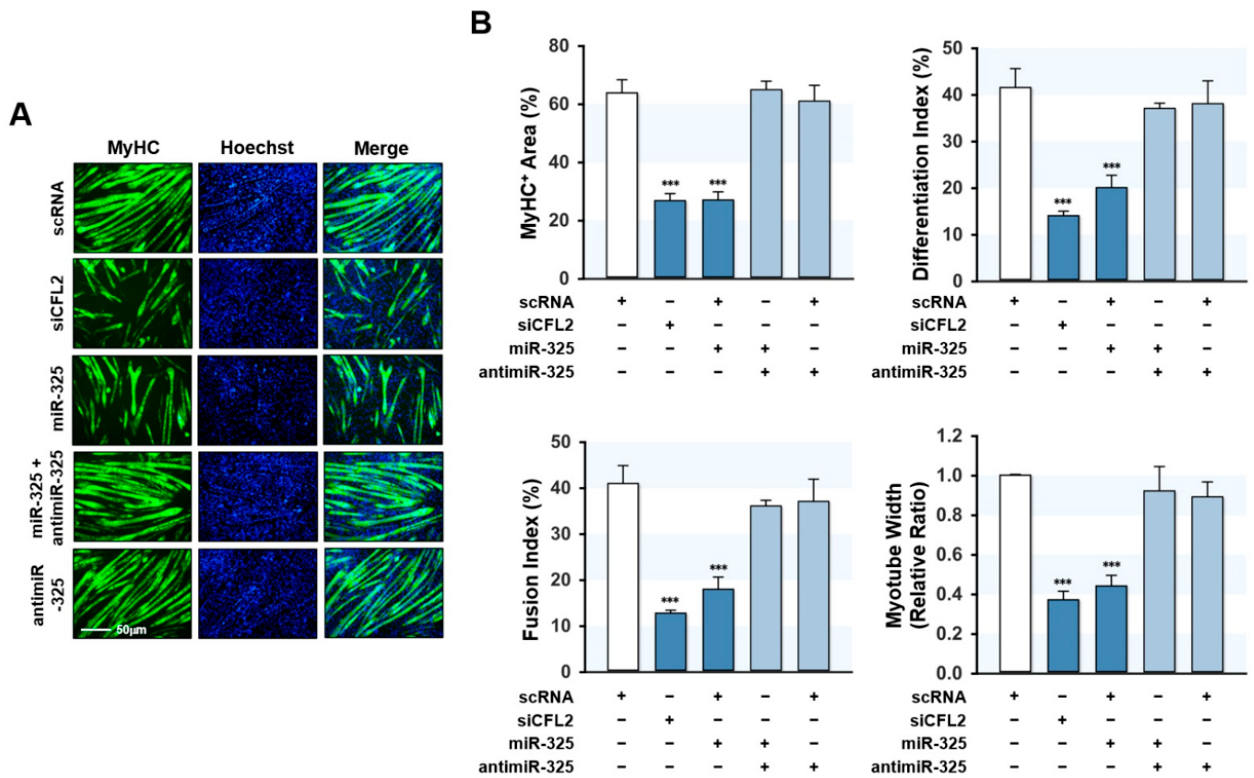
Figure 6. MiR-325-3p negatively regulated myogenic differentiation and myotube formation. C2C12 cells were transfected with 200 nM of scRNA, siCFL2, miR-325-3p mimic (miR-325), or antimiR-325-3p (antimiR-325) and differentiated for five days. ( A ) Representative immunocytochemistry with MyHC antibody (green) and Hoechst 33342 (blue). Scale bar: 50 μ m. ( B ) Quantitative analysis of MyHC-positive area, differentiation index, fusion index, and myotube width. All results are presented as the means ± SEMs ( n > 3), and levels of significance are presented as ***, p < 0.001 vs. scRNA controls.